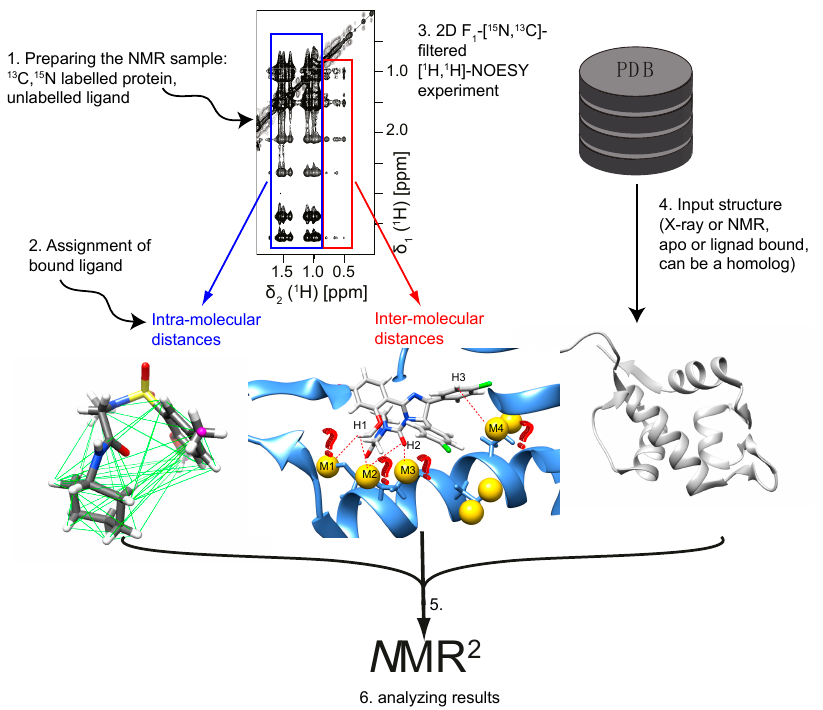
Figure 2. Overview of the N MR 2 method. The following steps are required for N MR 2 to determine the complex structure of the binding pocket: (i) Sample preparation for NMR measurements;